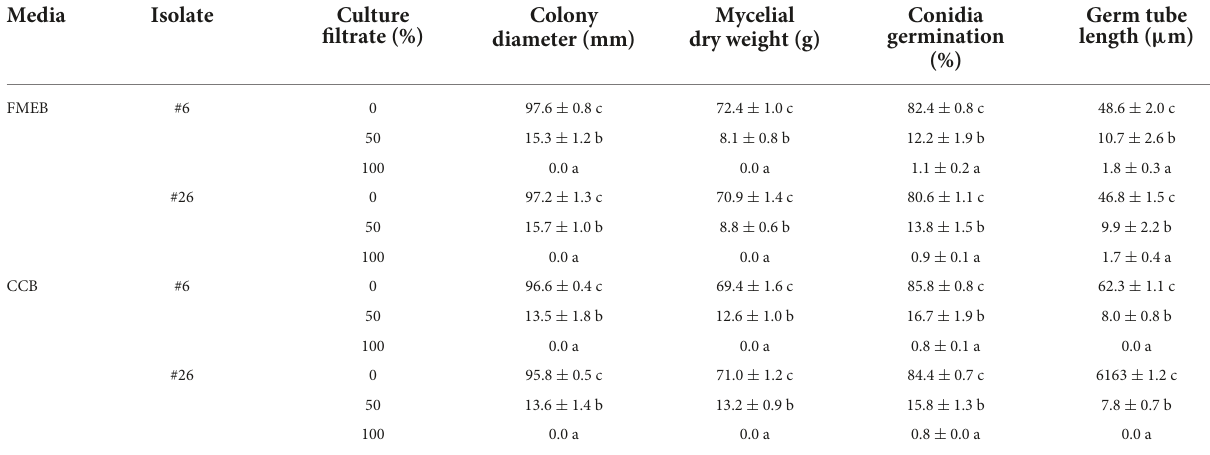
TABLE 2 Effects of the crude culture filtrate of the BCAs on the morphological characteristic of mycelia, conidia, and germ tube of Fusarium solani . Media Isolate Colony diameter